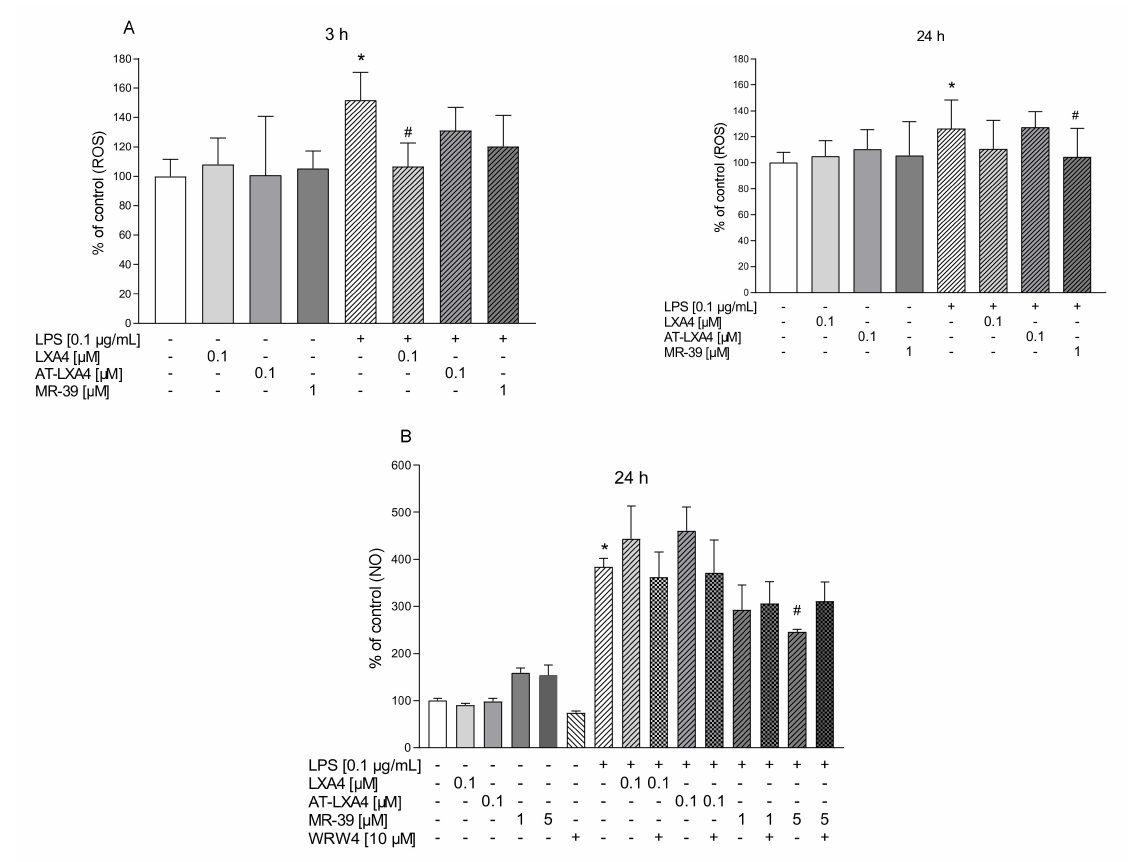
Figure 7. The impact of LXA4, AT-LXA4, and MR-39 on reactive oxygen species ( A ) and nitric oxide ( B ) release in rat microglial cultures. The cells were pretreated for 30 min with the FPR2 antagonist WRW4 (10 µ M). After that, LXA4 (0.1 µ M), AT-LXA4 (0.1 µ M), or MR-39 (1 µ M or 5 µ M) was added for 1 h, and then the cells were stimulated for 3 h or 24 h with lipopolysaccharide (LPS; 0.1 µ g/mL). Control cultures were treated with the appropriate vehicle. The data are presented as the mean ± SEM percentage of control (vehicle-treated cells) of independent experiments, n = 2–5 in each experiment. * p < 0.05 vs. control group, # p < 0.05 vs. LPS group. LXA4: lipoxin A4; AT-LXA4: aspirin-triggered lipoxin A4; LPS: lipopolysaccharide; ROS: reactive oxygen species; NO: nitric